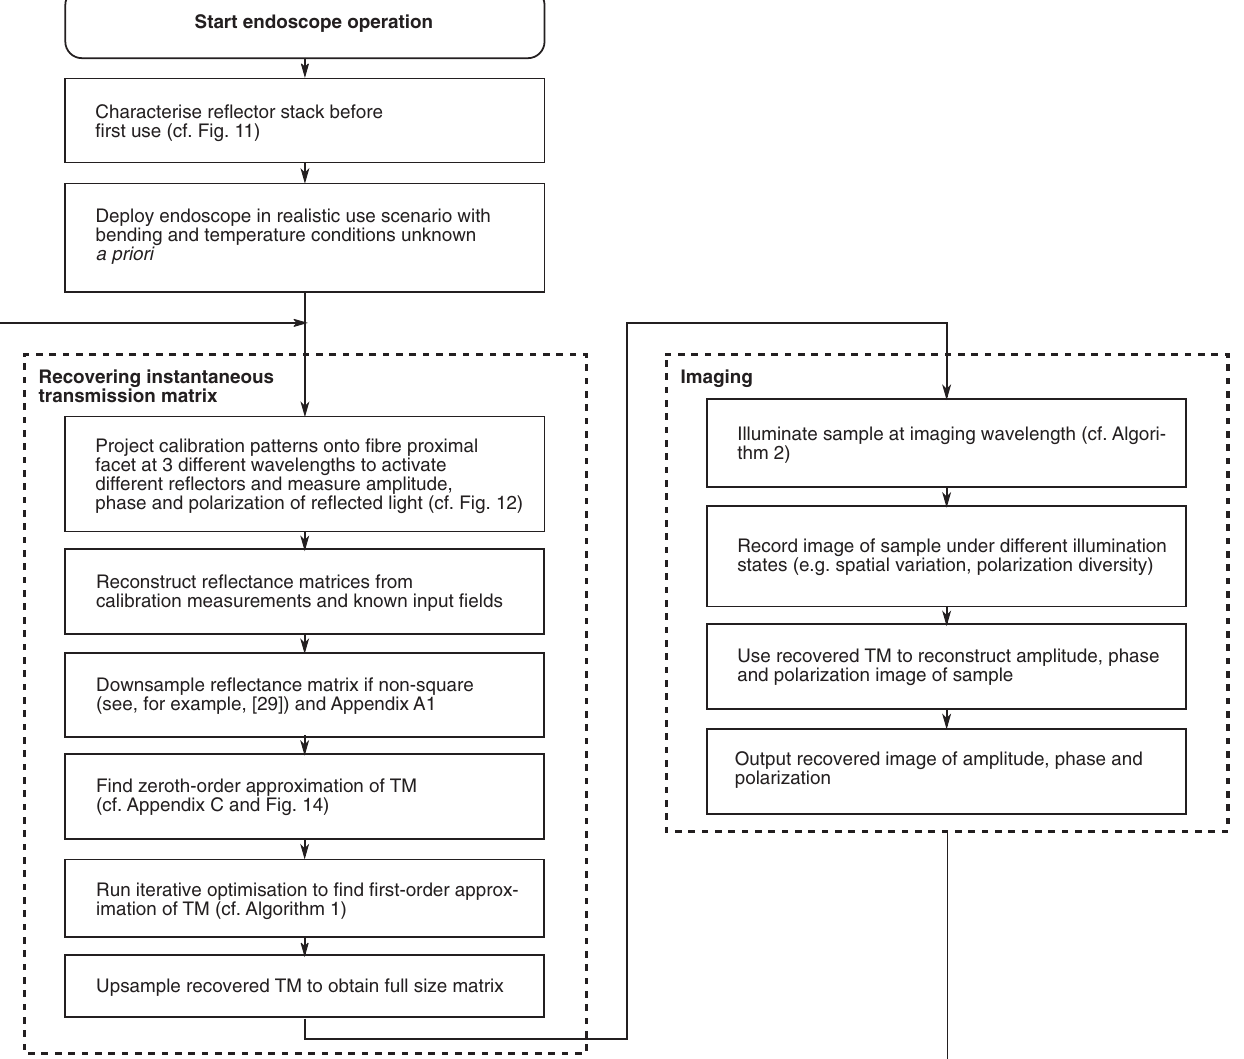
FIG. 10. Flowchart detailing the full process of TM recovery and imaging using the reflection mode endoscope setup. Details of specific subtasks are given in figures and sections as